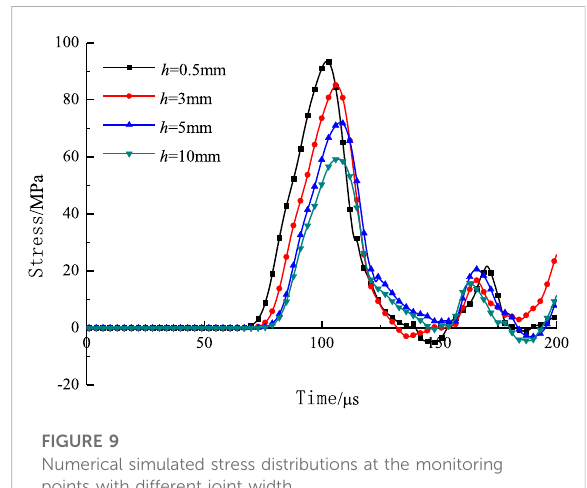
FIGURE 9 Numerical simulated stress distributions at the monitoring points with different joint